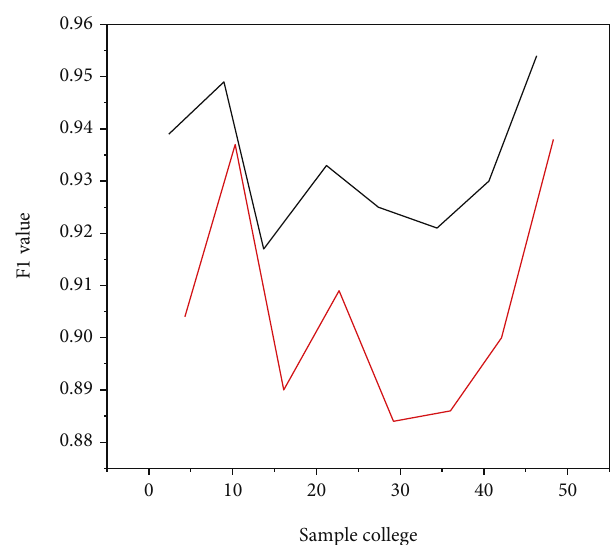
Figure 5: Comparison of label vector extraction e ff ects of di ff erent college samples.